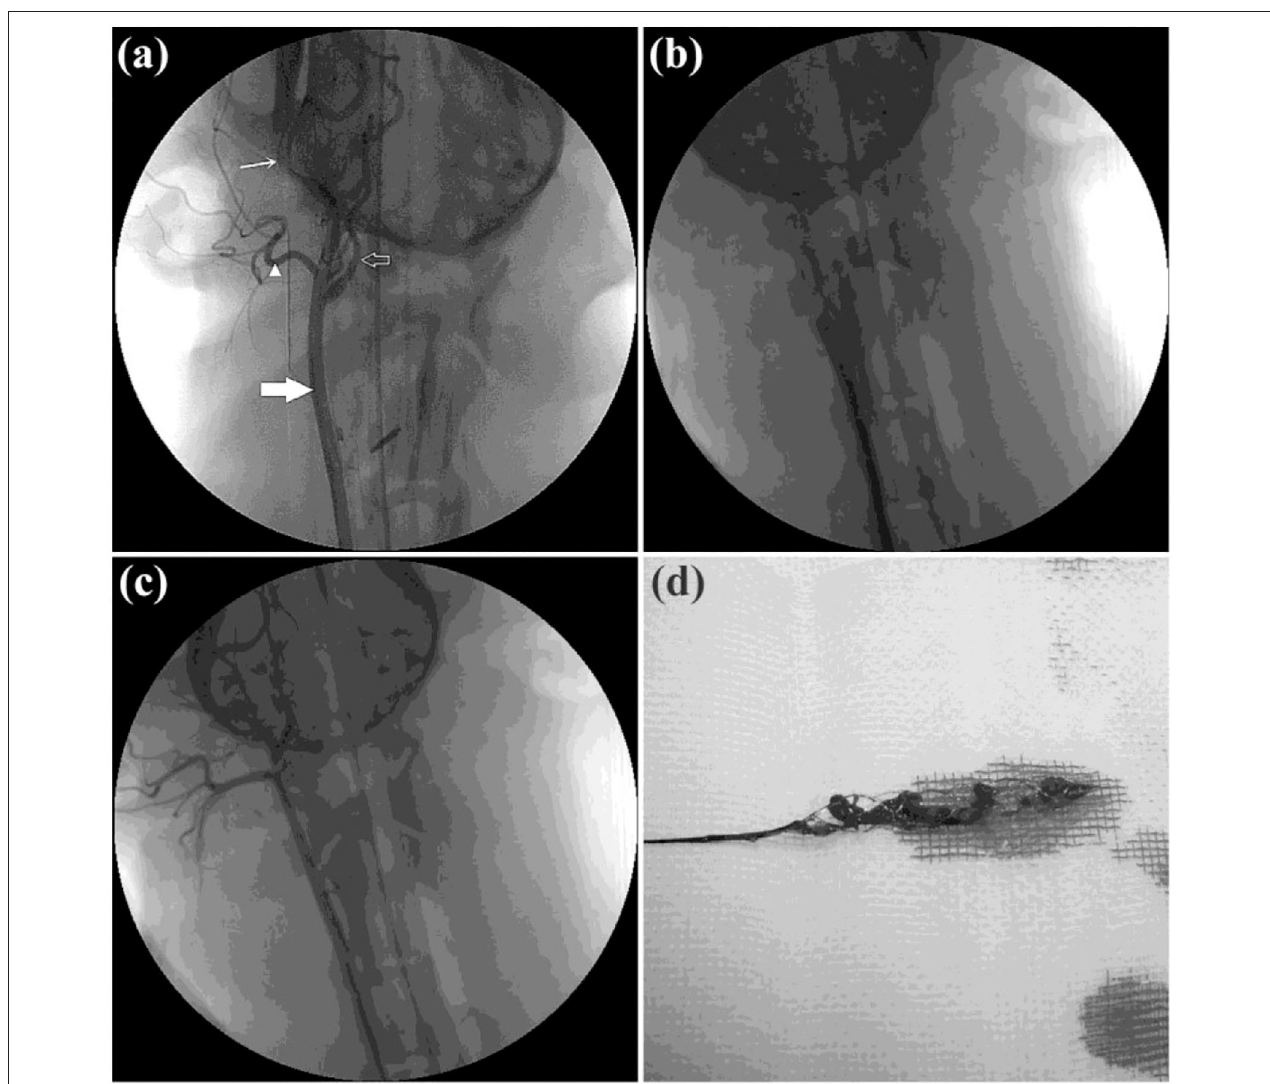
FIGURE 2 | Angiographic results of the thrombectomy in beagle dogs. (a) Baseline carotid artery angiography data of the beagle dog. Common carotid artery is indicated by the thick white arrow. Posterior ear artery is indicated by the white triangle. Maxillary artery is indicated by the fine white arrow. Internal carotid artery is indicated by the white hollow arrow. (b) Acute dog external carotid artery thromboembolism modeling was created successfully. (c) DSA immediately after thrombectomy. TIMI/TICI 3 flow was achieved immediately after retrieval of the Jrecan device. (d) Thrombus after